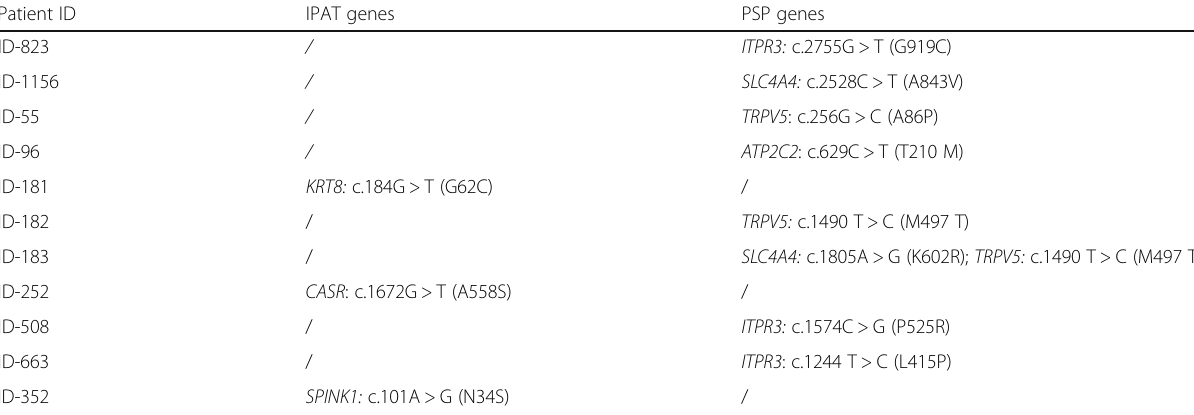
Table 4 Genotype of CFTR and mutations inintra-pancreatic activation of trypsin (IPAT) and pancreatic secretion pathway (PSP) genes in in healthy